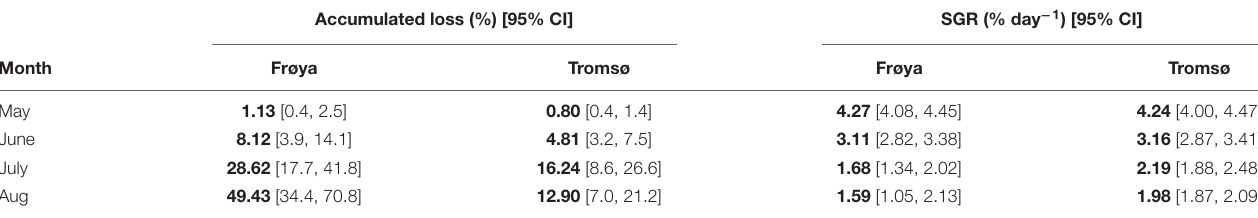
TABLE 3 | Comparison of accumulated loss and SGR between Frøya and Tromsø February deployment for selected months and also showing 95% confidence intervals (CI) for the estimates.